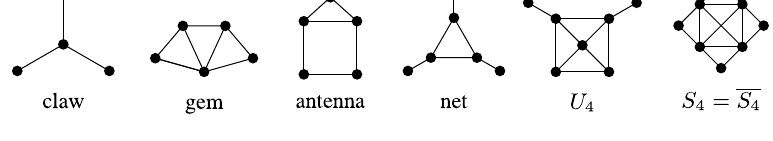
Fig. 3: Some small graphs